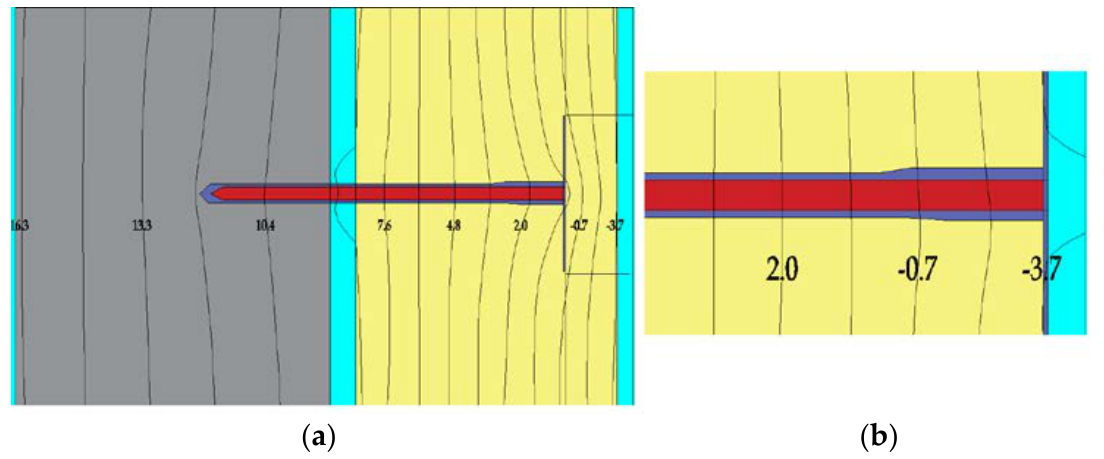
Figure 10. Compared distribution of isotherms for two mounting types of the connector: ( a ) mounting with Styrofoam, ( b ) mounting without Styrofoam plug (author’s archives based on [59]).